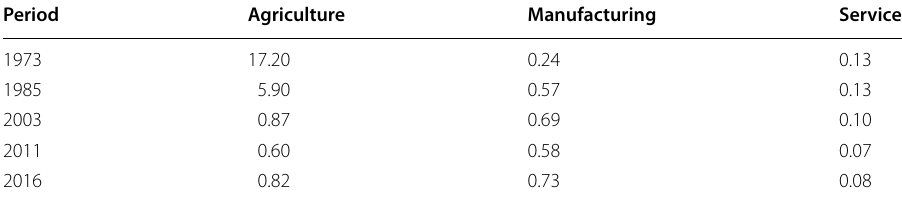
Table 12 Ratio of export to import by sector in Turkey. Source : Author’s calculation. Ratios were calculated by deriving data from TurkStat